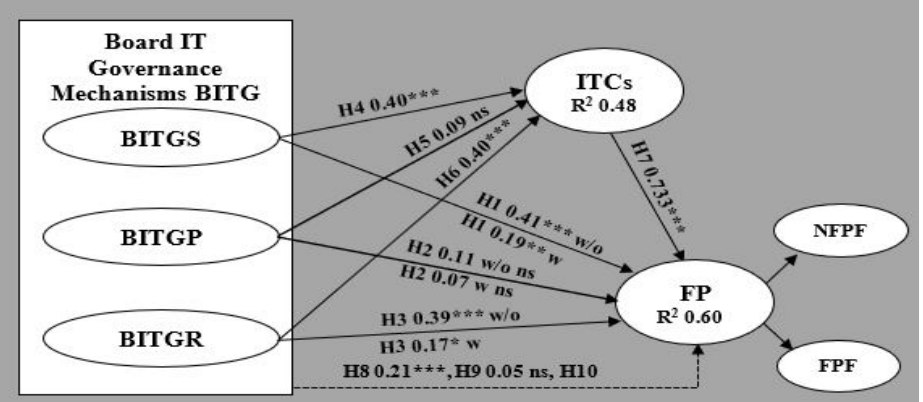
Figure 2. Estimated model. Note: *, **, and *** are the significance levels at 5%, 1%, and 0.1%, respectively; ns = not significant (2-tailed). Table 4. Results of the first three causal steps of the Baron and Kenny